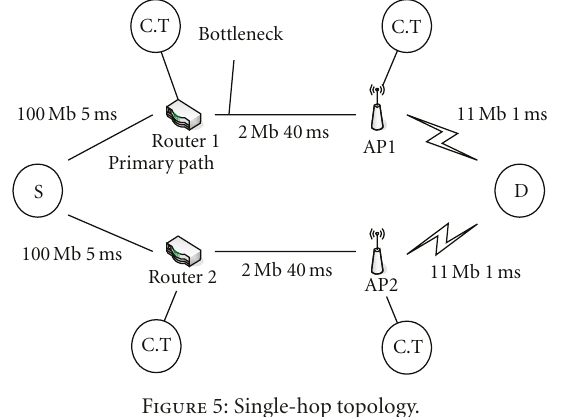
Figure 5: Single-hop topology.